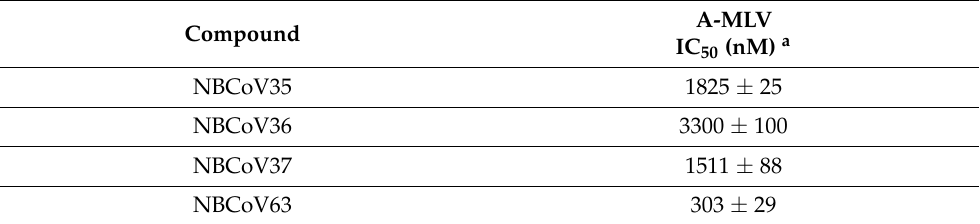
Table 6. Antiviral activity of the NBCoV compounds in a single-cycle assay in 293T/ACE2 cells against control pseudovirus NL4-3 ∆ Env